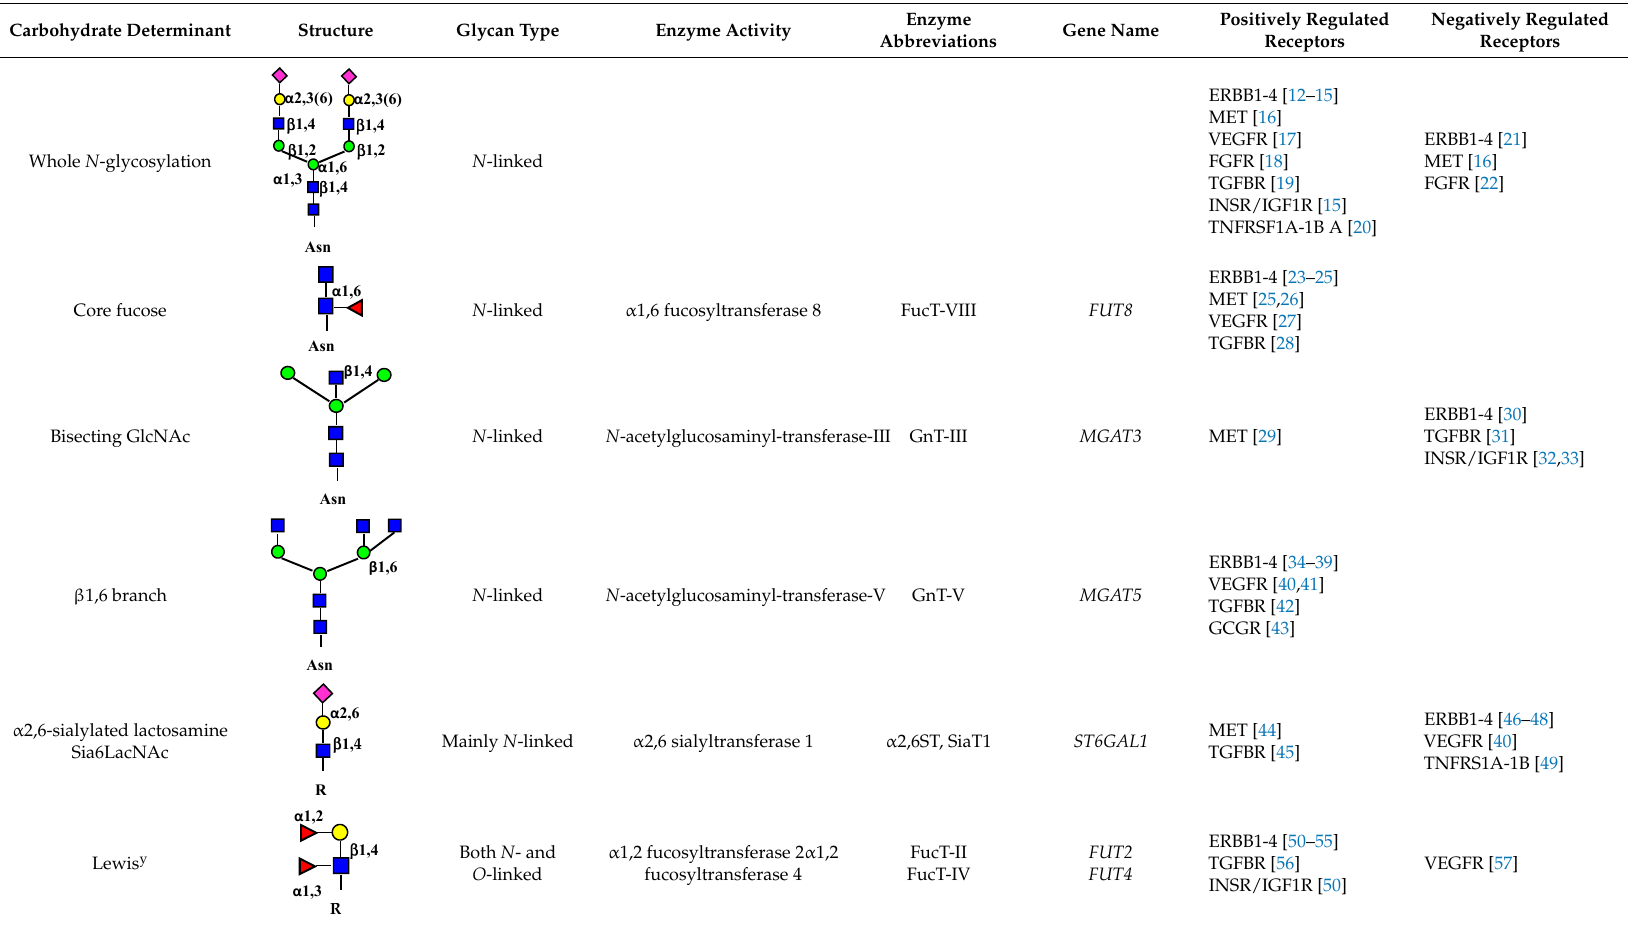
Table 1. Glycan structures involved in the regulation of receptor activity.